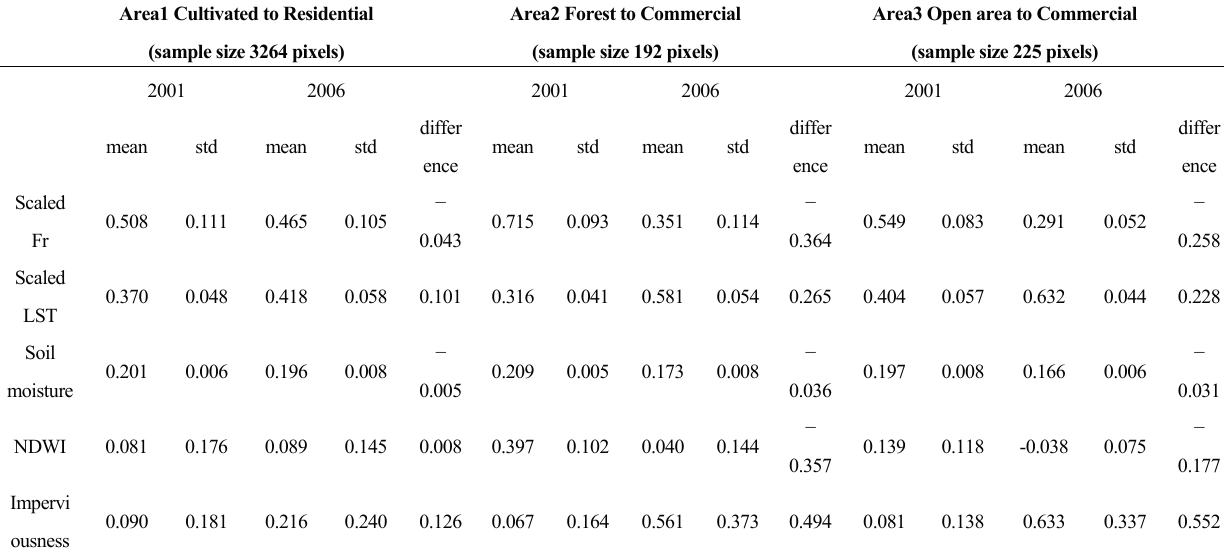
Table 1. The mean and standard deviation of scaled vegetation fraction (Scaled Fr), scaed LST, soil moisture, NDWI, and percentage of impervious surface in 2001 and 2006.